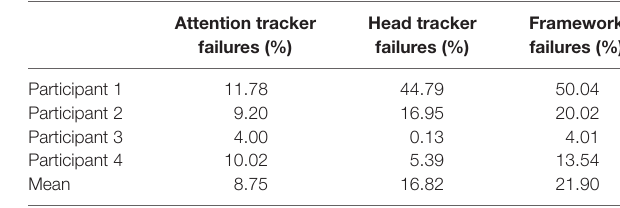
Table 1 | Attention tracking performance measurements.